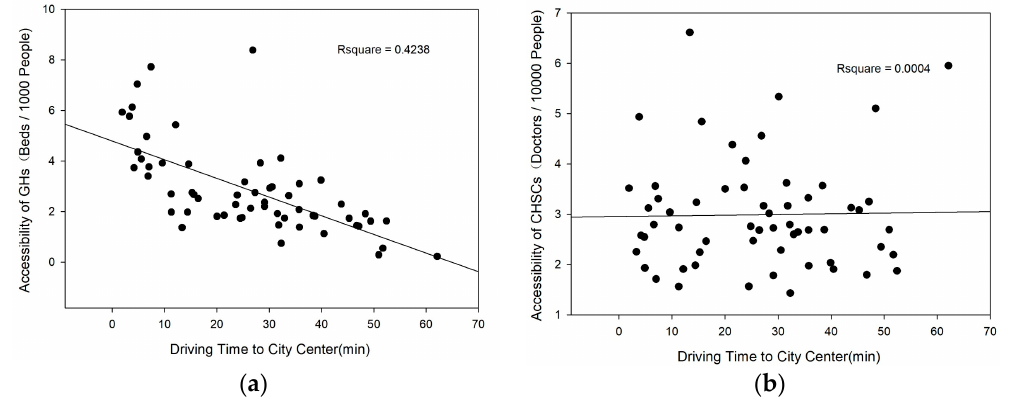
Figure 3. The relationship between driving time to city center and the accessibility. (a) The relationship between driving time to city center and the accessibility of GHs; ( b ) The relationship between driving time to city center and the accessibility of CHSCs.